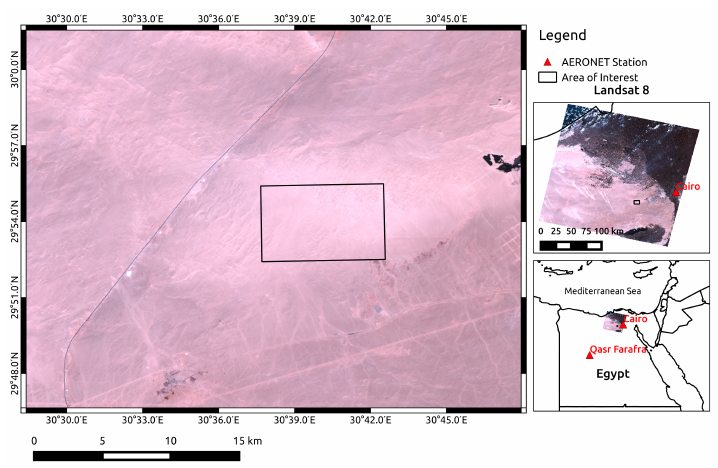
Figure 1. The rectangle is the study area located in the southwestern Nile Delta. The geographical coordinates in the reference system WGS84 are shown along the border of the map. The AERONETstations are shown by red triangles.